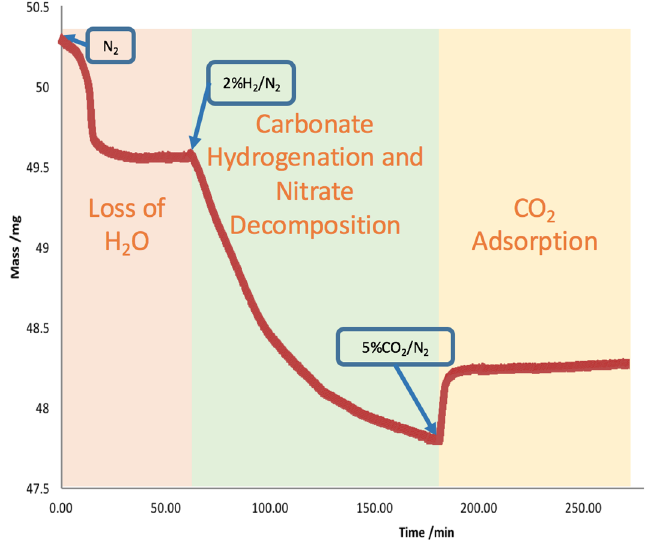
Figure 2. TGA result of Ru salts and carbonate hydrogenation study operated at 320 ◦ C for 50 mg of 1.44% Ru/Na 2 CO 3 powder sample.